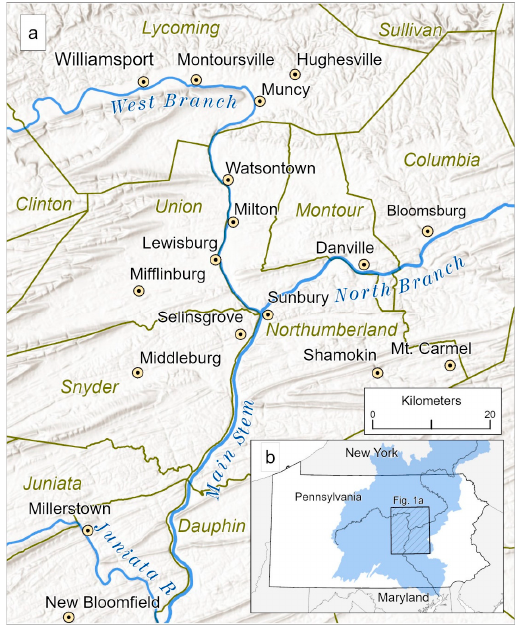
Figure 1. ( a ) Map of central Pennsylvania showing towns and county names, centered on the study region at the confluence of the branches of the Susquehanna River, and ( b ), its location within Sus- quehanna River